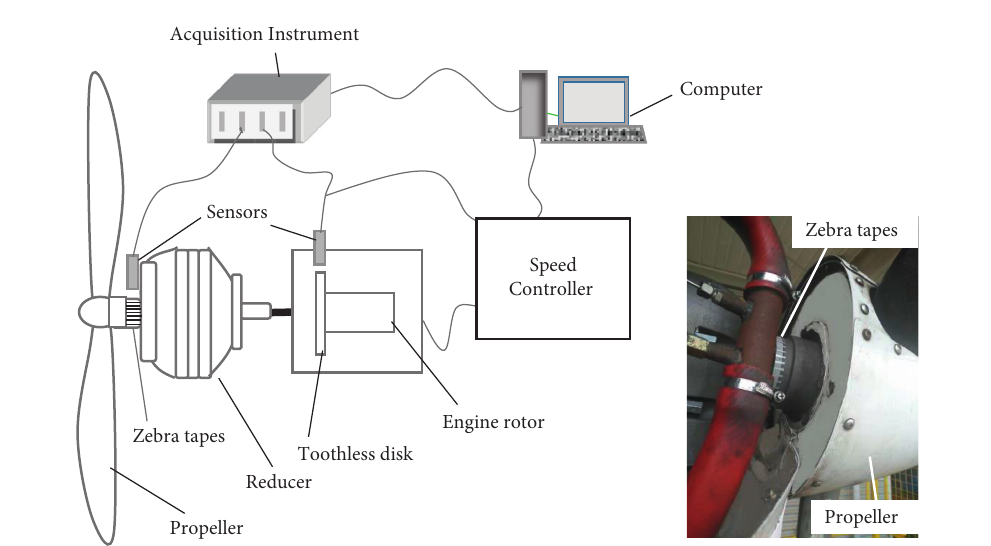
Figure 16: The torsional vibration test